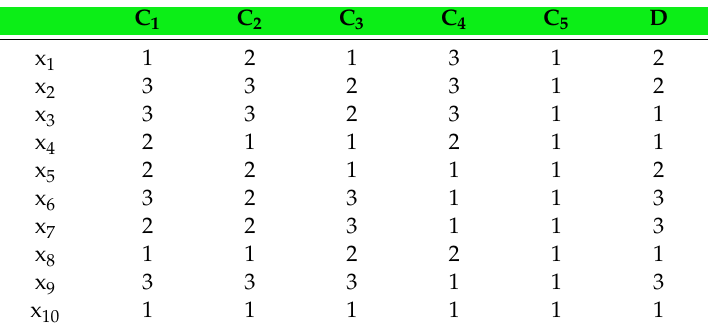
Table 1. Example